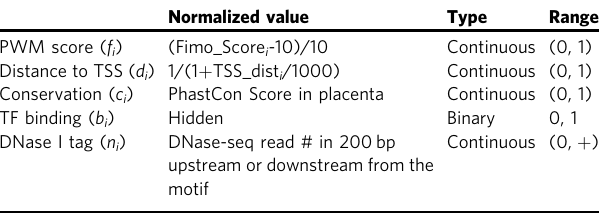
Table 1 Bayesian Network Model